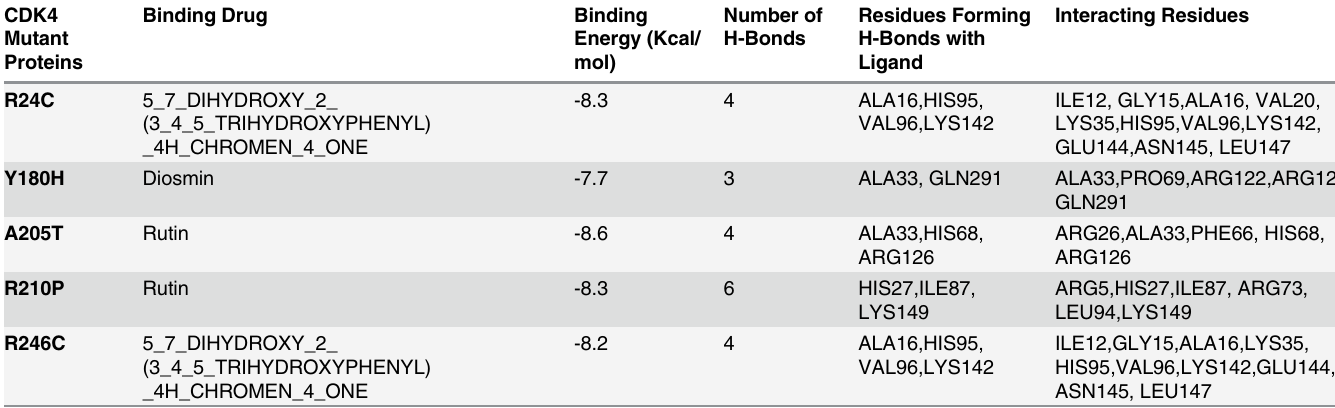
Table 4. Virtual compounds with highest binding energy with CDK4 mutant